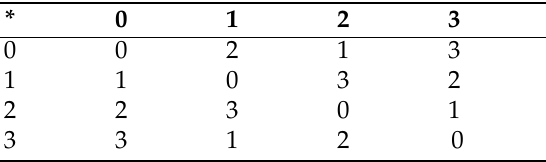
Table 1. Cayley table for the binary operation “ ∗